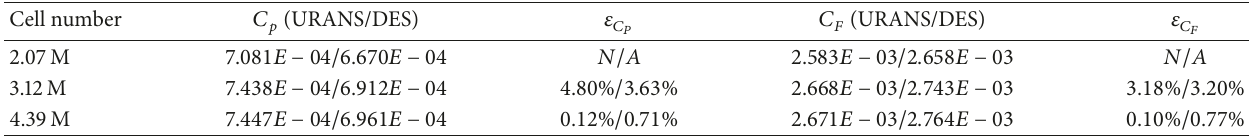
Table 2: Grid refinement study based on predicted ship resistances.